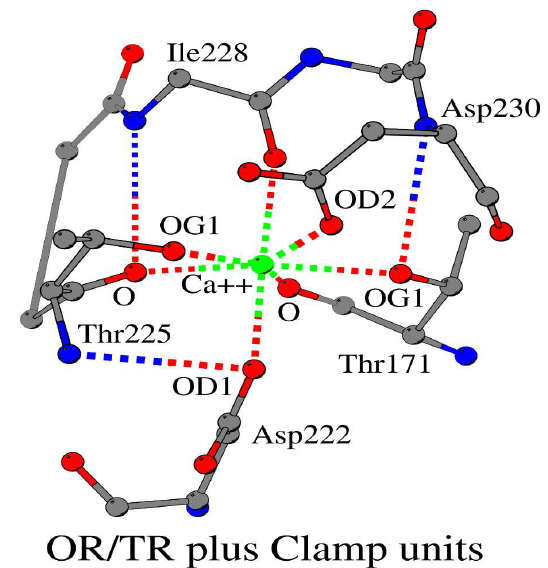
Figure 3. Atomic cation-binding network in peroxidase. Three OR/TR and three Clamp units are shown.